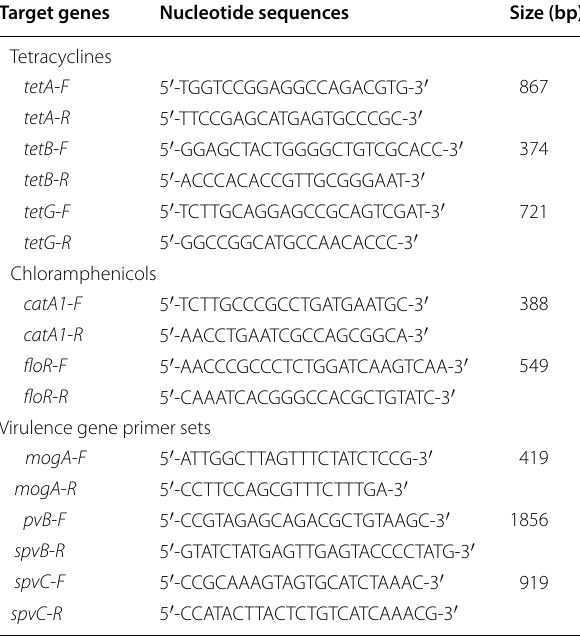
Table 1 Primers used for PCR amplification Target genes Nucleotide sequences Salmonella spp. detection primer sets